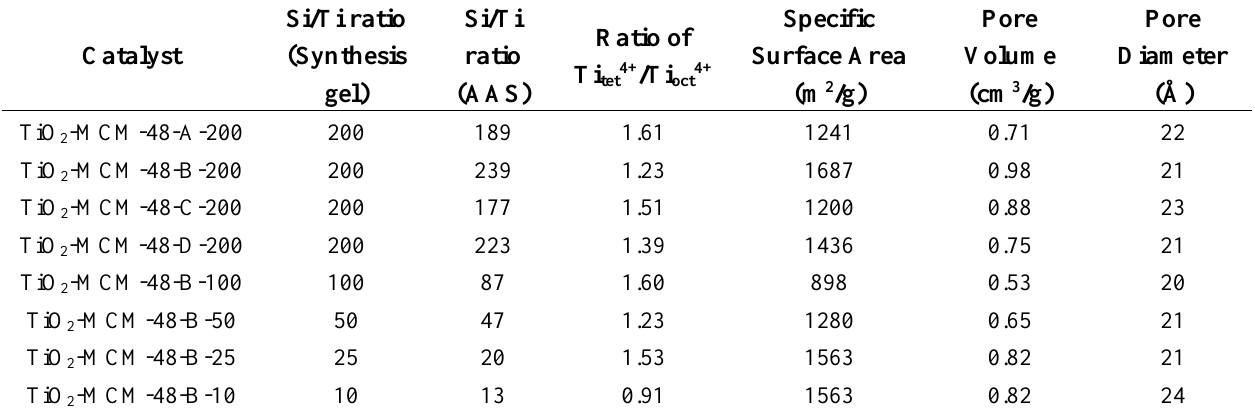
Table 1. Summary of physico-chemical properties of TiO 2 -MCM-48 mesoporous materials.